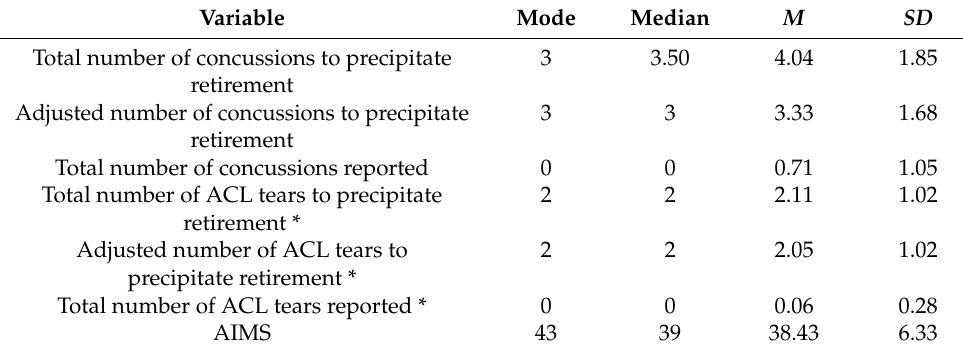
Table 1. Descriptive statistics for main outcome measures.